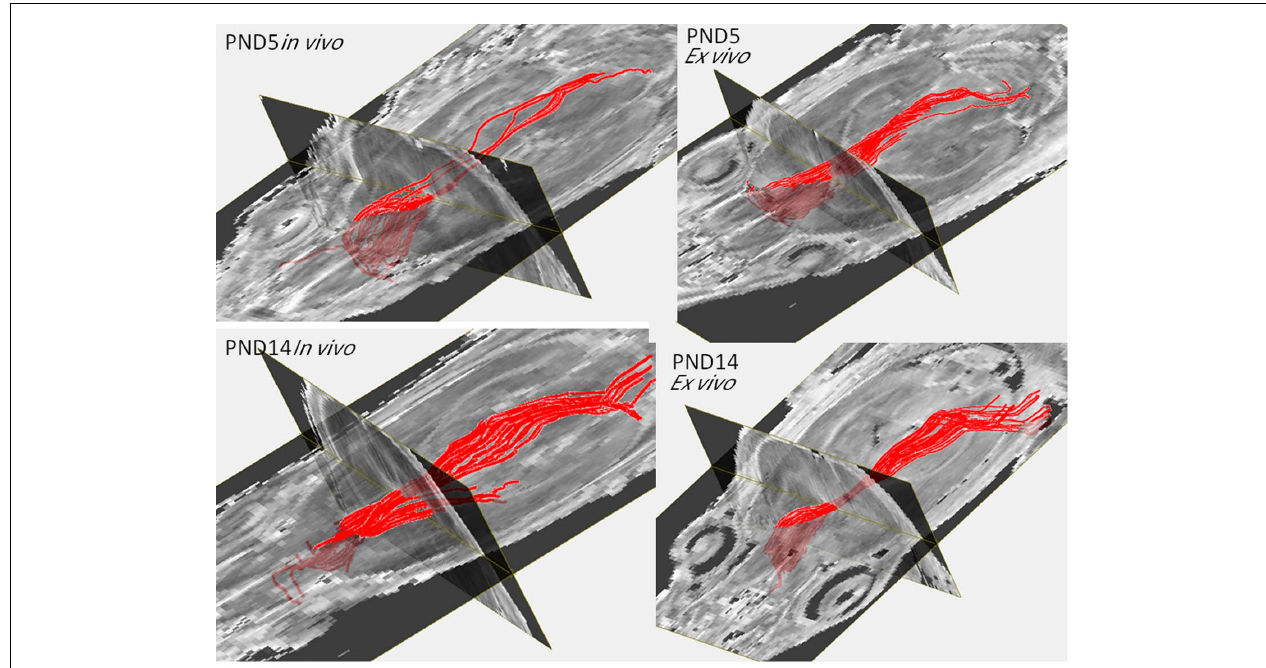
FIGURE 4 | Fiber tractography obtained from the in vivo and the ex vivo PND5 and PND14